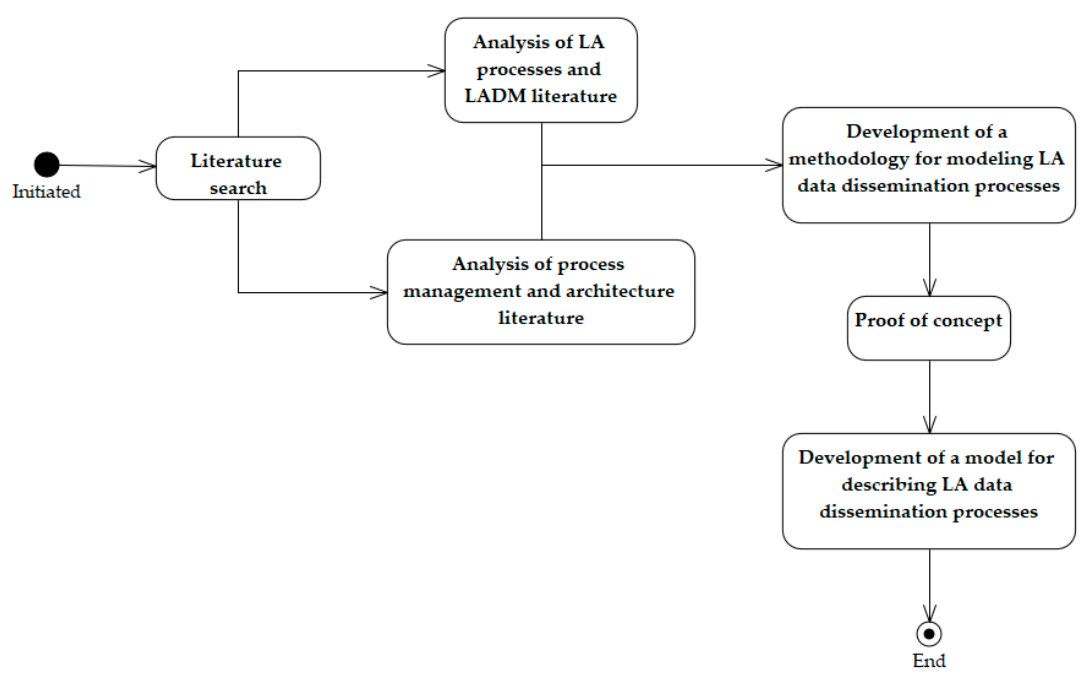
Figure 1. Research work fl ow. Source: Own compilation.